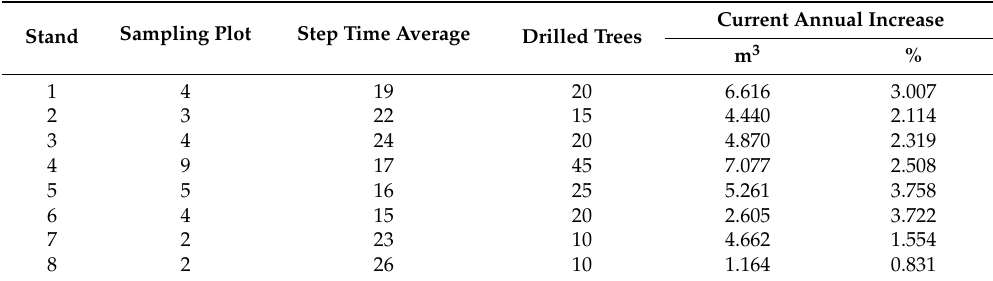
Table 3. Result of calculating volumetric